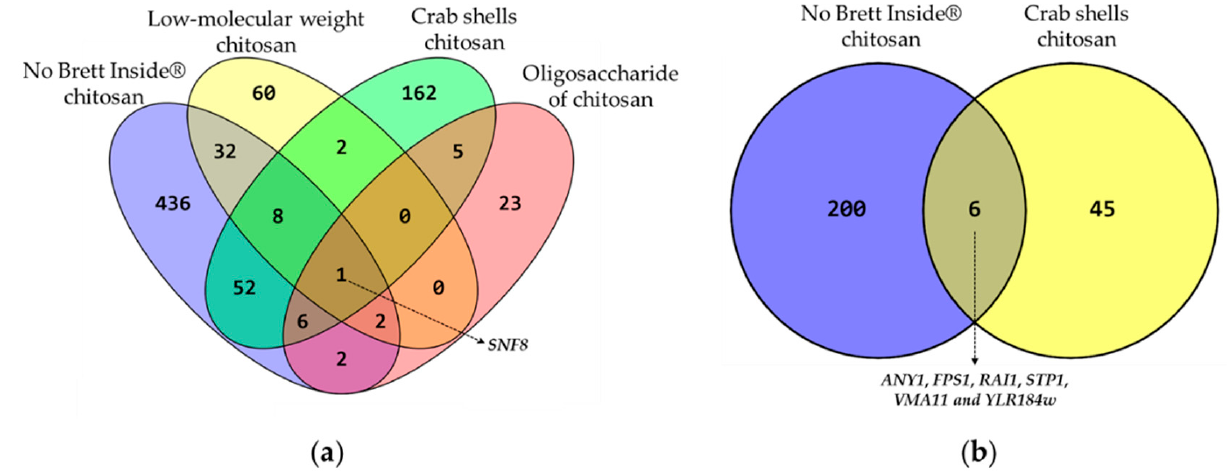
Figure 3. Venn diagrams indicating the number of overlapping genes whose deletion was found to confer a susceptibility phenotype ( a ) or a resistance phenotype ( b ) with other previously published studies, using different origins of chitosan, namely low molecular weight (LMW) [38]; chitosan from crab shells [44]; chitosan oligosaccharide (COS) [50] and No Brett Inside ® (this study). Functional clustering of the genes shown to provide protection to the commercial formulation of chitosan used shows that the highest number of those are involved in “intracellular trafficking”, in “translation”, and in “transcription”, as detailed in Figure 4 and in Table 2.